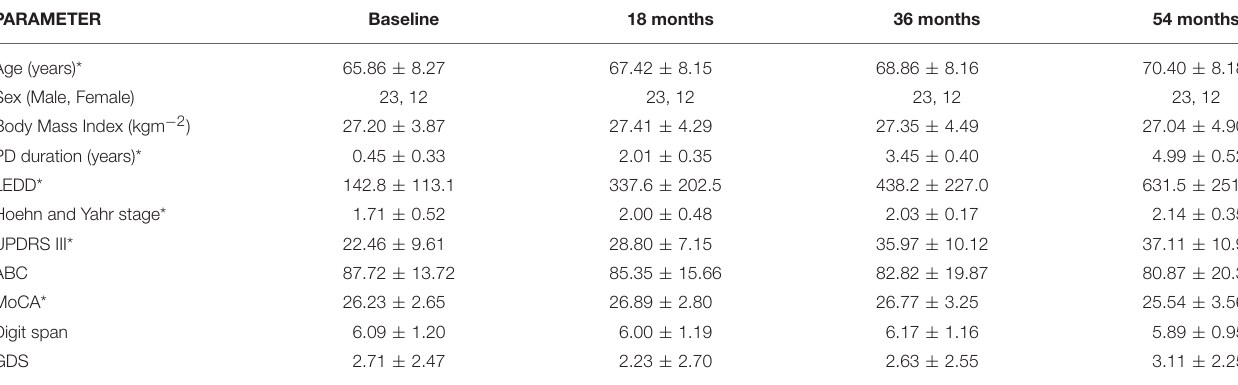
TABLE 1 | Demographic, cognitive, and clinical characteristics of participants at Baseline, 18, 36, and 54 months. PARAMETER